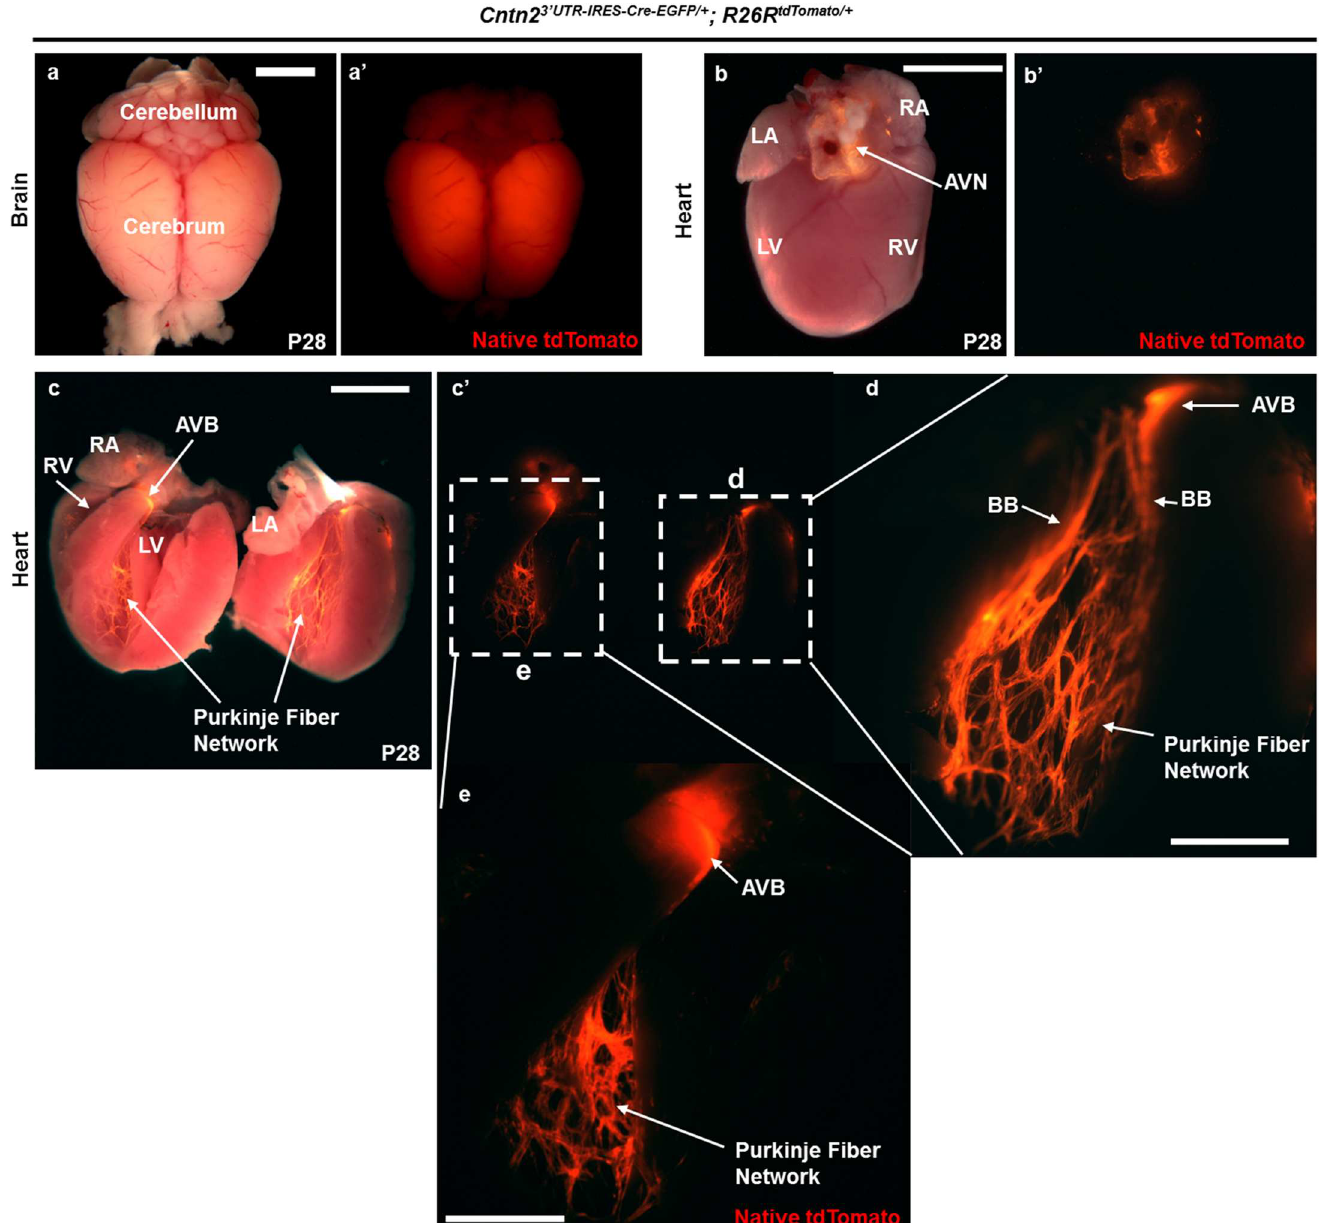
Fig 2. Cntn2 3’UTR-IRES-Cre-EGFP/+ ; R26R tdTomato/+ mice display robust reporter expression in the VCS. (a-e) Cntn2 3’UTR-IRES-Cre-EGFP/+ mice were bred with R26R tdTomato/tdTomato reporter mice to characterize the Cntn2 3’UTR-IRES-Cre-EGFP/+ alleleby monitoring tdTomato expressionat P28 by whole mount fluorescence imaging(a and a’) in brain (dorsal view, used as a positive control) where endogenousContactin 2 is known to be expressed abundantly and (b-e) in heart. We monitored tdTomato expressionin at least 15 independent Cntn2 3’UTR-IRES-Cre-EGFP/+ ; R26R tdTomato/+ mice from multiplelitters in comparisonto 12 WT control littermates. (b and b’) Native tdTomato fluorescence was visualizedat the Atrio-Ventricular Junction(AVJ) by whole-mount microscopyfollowingCre recombination of the R26R locus. (c-e) A P28 mouse heart was sectionedgrossly in the four-chamber orientationto visualizenative tdTomato expressionin the VCS. (c and c’) Robust tdTomato fluorescence was observedin the Atrio-Ventricular Bundle (AVB), right and left BundleBranches(BB), and right and left PurkinjeFiber (PF) network. Faint speckledfluorescent signal was also observedin the Right Atrium (RA) (not visiblein the image). (a-c) Scale bar: 500 μ M. (d and e) Highermagnification images of (d) right inlet in (c’) and (e) left inlet in (c’) to visualizethe intricate structures of AVB and highly branched PF network in the adult mouse heart. Scale bar: 250 μ m. LA, Left Atrium; LV, Left Ventricle; RV, Right